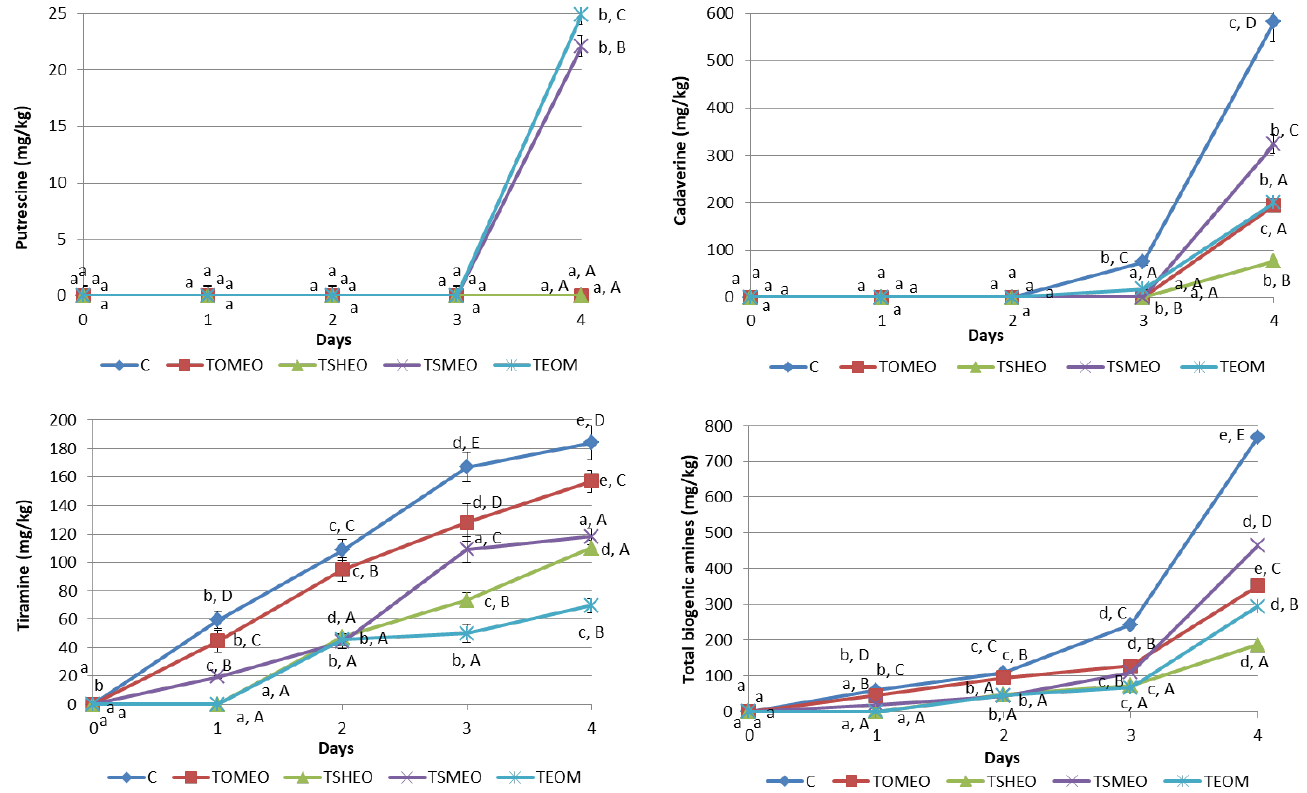
Figure 2. Evolution of biogenic amines (mg/kg) in fresh turkey sausages during storage. TOMEO — 0.150 µL/g O. majorana essential oil; TSHEO — 0.150 µL/g S. hortensis essential oil; TSMEO — 0.150 µL/g S. montana essential oil; TEOM — 0.050 µL/g O. majorana essential oil; 0.050 µL/g S. hortensis essential oil; and 0.050 µL/g S. montana essential oil; Control (C). Different upper cases (A – E) indicate difference ( p < 0.05) between treatments at the same storage day. Different lower cases (a – e) indicate difference ( p < 0.05) between different storage day, for each treatment.